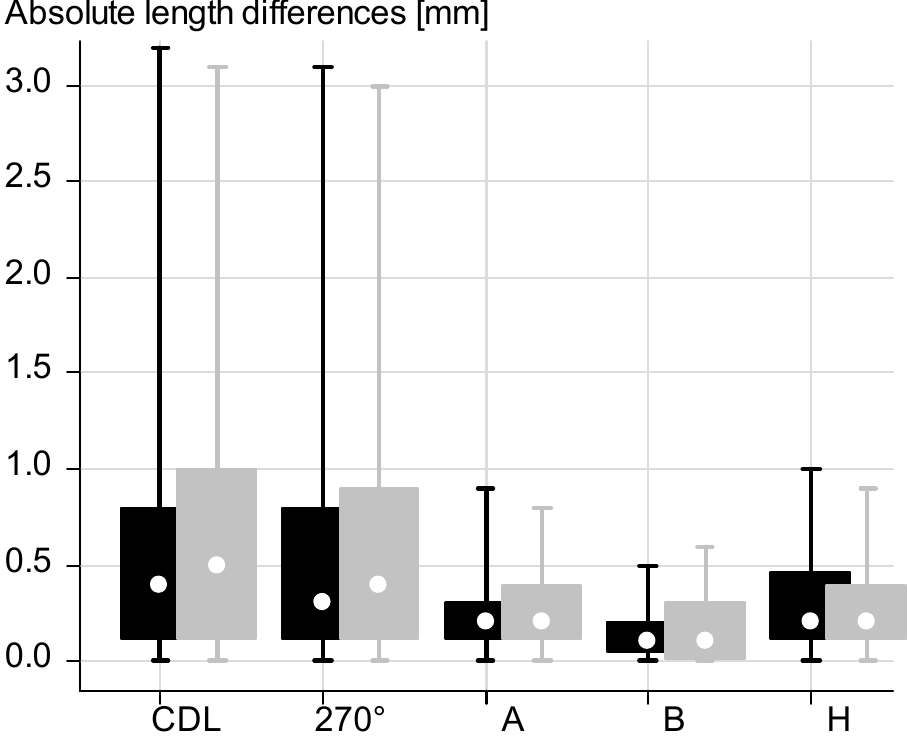
Figure 3. Absolute intrarater differences of length parameters based on CT vs. MRI for the left (black) and right ear (grey), CDL= cochlear duct length, 270° = length at 720°, A = length of diameter A, B = length of width B, H = length of height H.